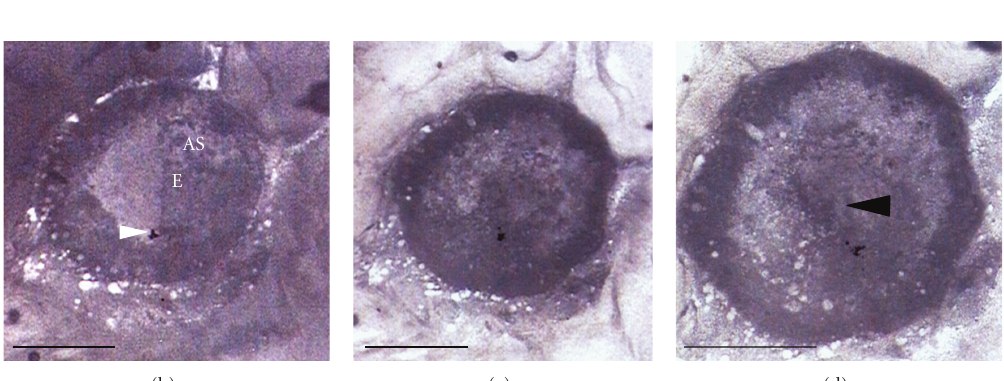
Figure 10: (a): Schematic representation of the surgical removal of the right half of the endophyll-Rauber’s sickle (RS) complex of an unincubated chicken blastoderm. The top of the sickle horns (SH) is fragmentary (in green) and cannot always be distinguished. AS, anti- sickle region; CMZ, caudal marginal zone; CGW, caudal germ wall; L, left of the blastoderm; the red arrow indicates where the symmetrically formed primitive streak will appear after incubation. (b): Removal of the endophyll-Rauber’s sickle complex at the right side as represented in Figure 10(a), at the start of the culture period. A graphite particle, indicated by white arrowhead, is placed in the middle region where Rauber’s sickle is sectioned. E: half left endophyll sheet; Bar = 2 mm. (c): The same blastoderm as seen in Figure 10(b) after 5 hours of culture; a darker linear area has appeared at the operated side. Bar = 2mm. (d): The same blastoderm as seen in Figure 10(c) after 9 hours of culture. A primitive streak (indicated by arrowhead) starting from the graphite particle is localized in a clearer area (a realization) and is directed to the unoperated side. Bar = 2